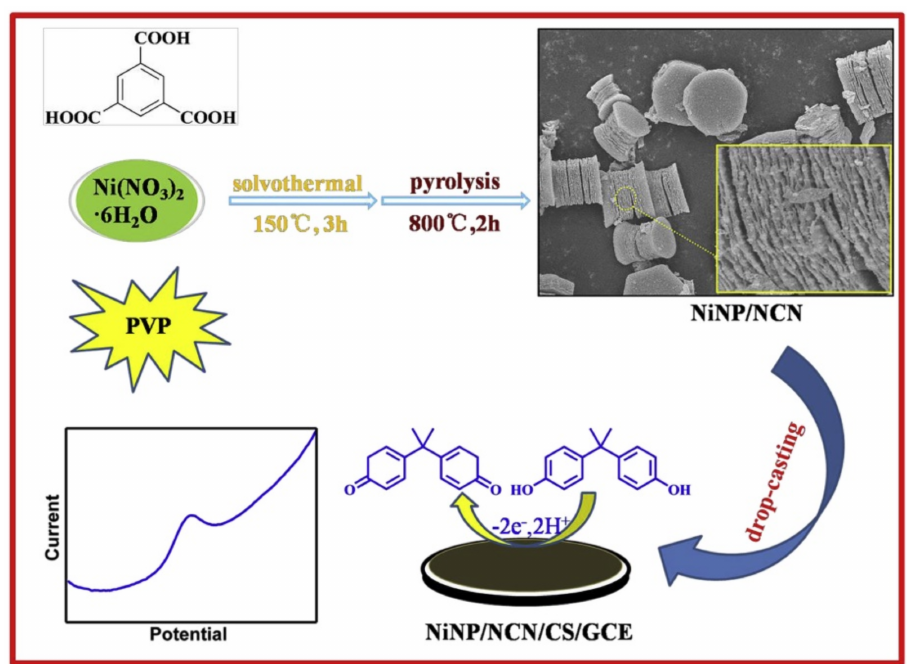
Figure 10. Synthesis of a three-dimensional hierarchical cylinder-like NiNP/NCN nanocomposite, and the assembling steps of a NiNP/NCN/CHI/GCE-based electrochemical BPA sensor. Reprinted with the permission from reference [116]. Copyright 2020